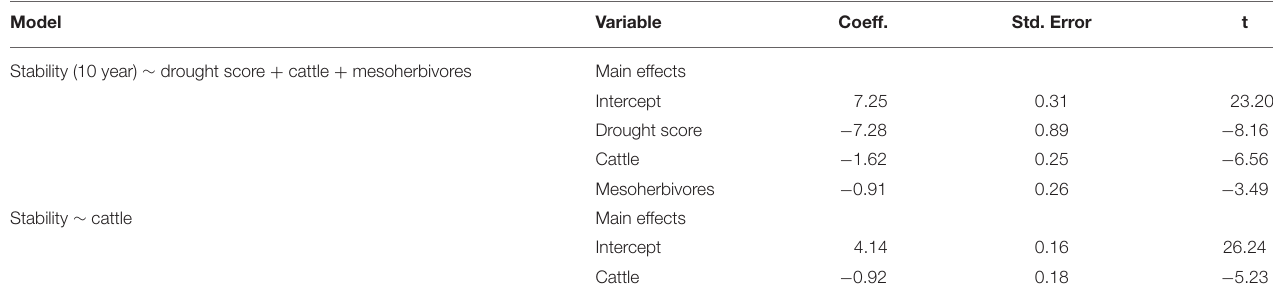
TABLE 1 | Model outputs from linear mixed effects models predicting stability and selected for the lowest AIC c value. Model Variable Coeff. Std. Error